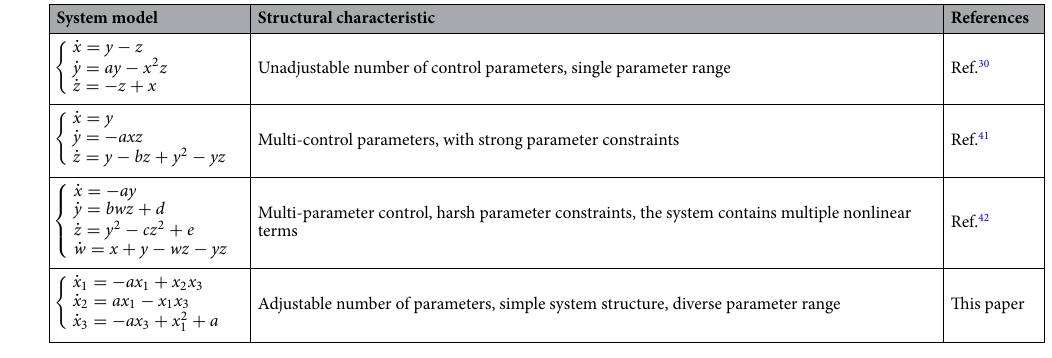
Table 1. Comparison of structural features with other systems.